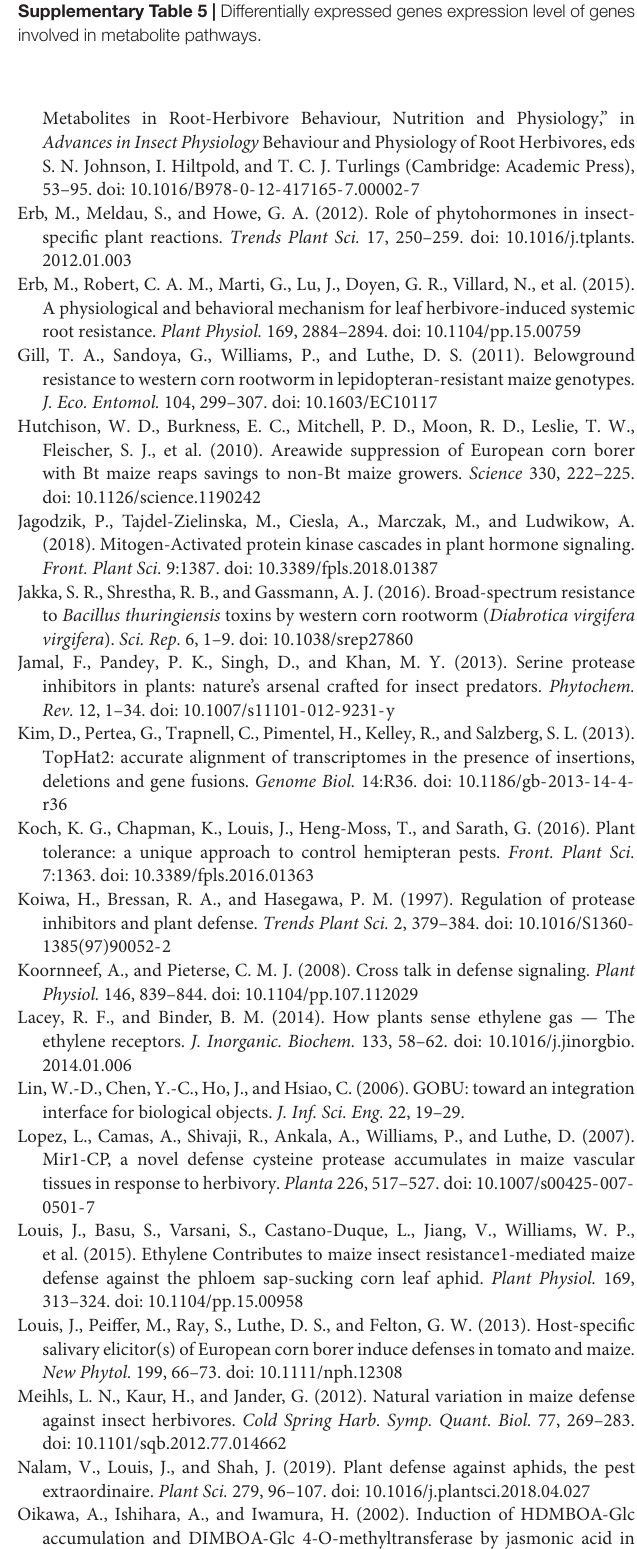
Supplementary Table 2 | Differentially expressed genes function enrichment. (C: cellular component, F: molecular function and P: biological process). Supplementary Table 3 | Transcription factor (TF) families